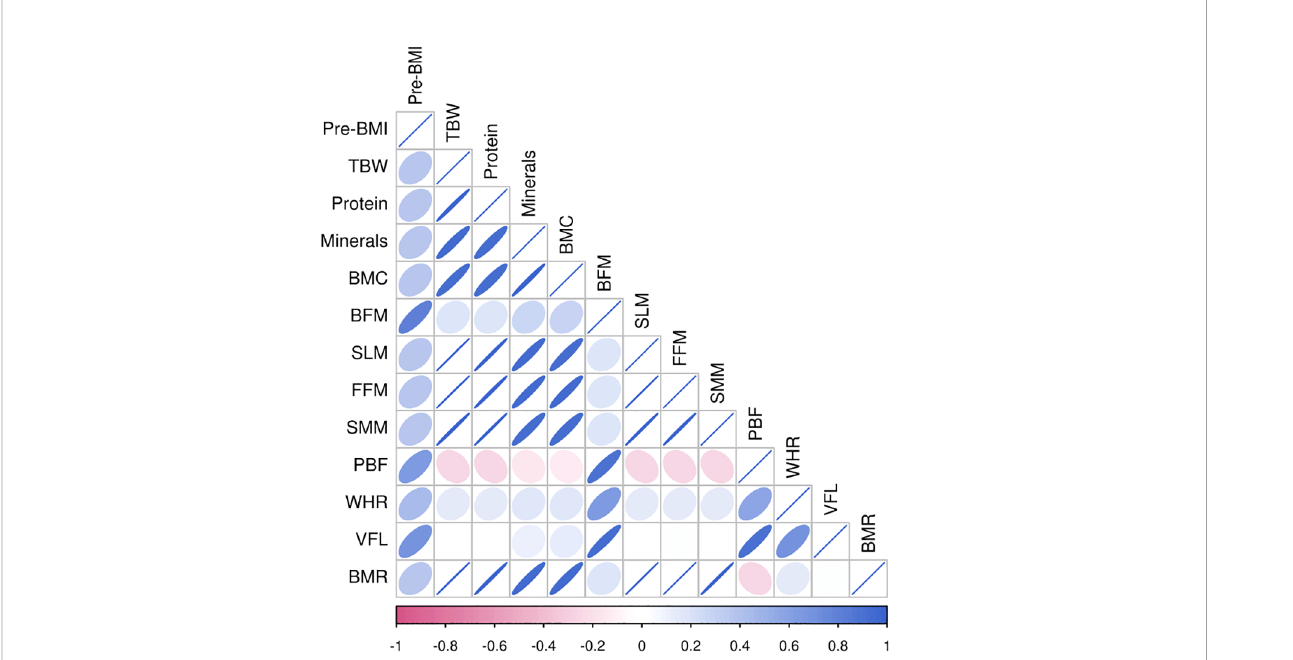
FIGURE 3 Heat map of body composition correlation in pregnant women with pre-pregnancy BMI < 24kg/m 2 .